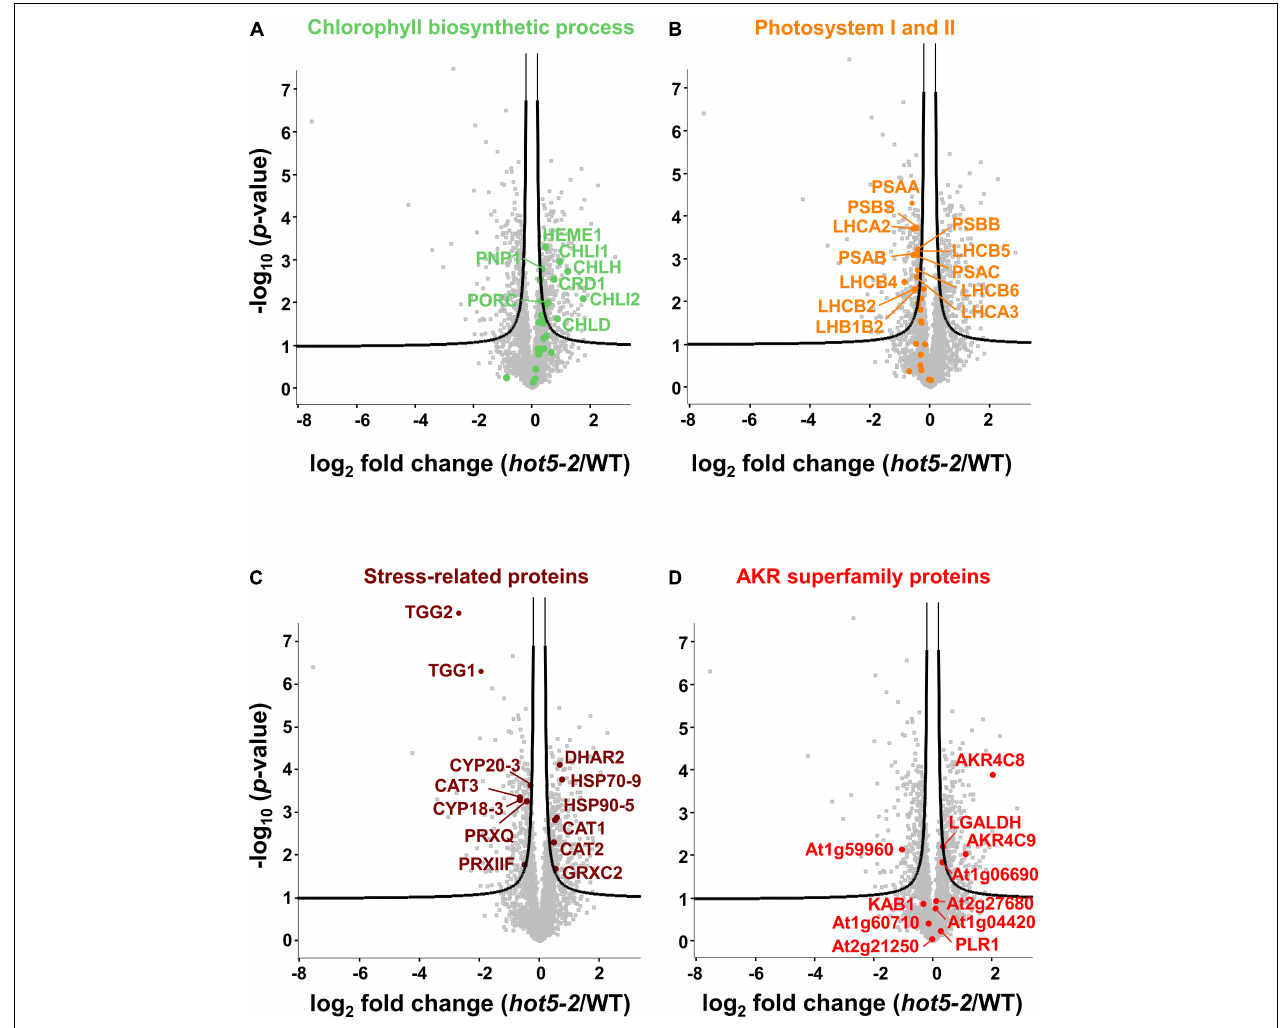
FIGURE 2 | Volcano plots of differentially expressed proteins. Proteins associated with chlorophyll biosynthesis ( A ; GOBP term: chlorophyll biosynthetic process), photosystem I and PSII ( B ; GOCC: photosystem I and PSII), and selected stress-related proteins (C) are illustrated. (D) Proteins belonging to the AKR protein superfamily (PFAM ID: PF00248) are labeled. The –log 10 of the corrected p -values is plotted against the log 2-fold change (FC) in protein levels. FDR cutoff (5%) is indicated by black lines. A list of the significantly regulated proteins is provided in Supplementary Data Set 1